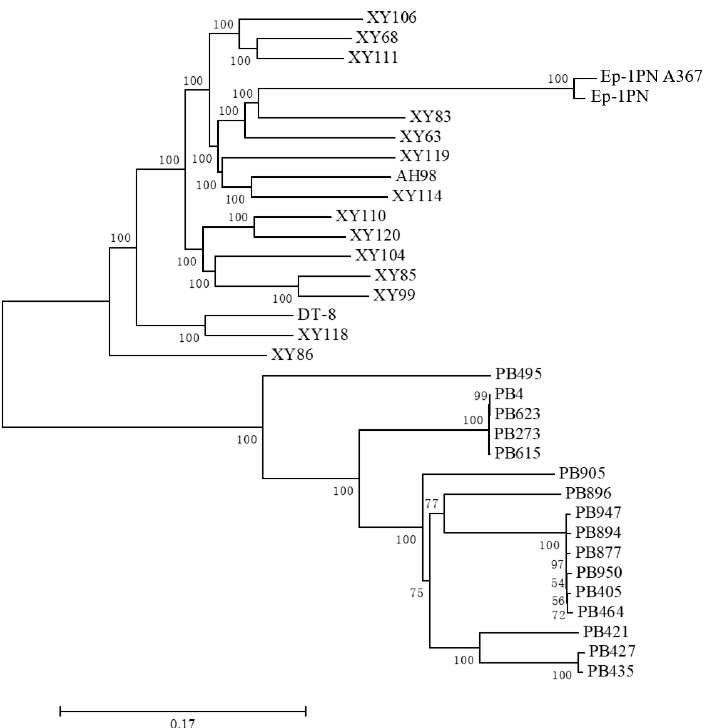
Figure 4. A genome-wide SNP-based phylogenetic analysis for all S. sclerotiorum strains in this study. An SNP-based neighbor-joining (NJ) tree was constructed. For details, see Methods. Branch length corresponds to genetic distance based on the SNP number between each other. Bootstrap values (%) obtained with 1000 replicates are indicated on branches. The scale bar corresponds to a genetic distance of 0.1.